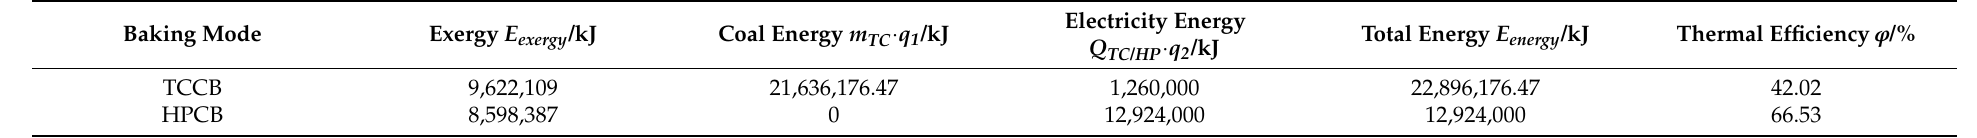
Table 10. The thermal efficiency of bulk curing